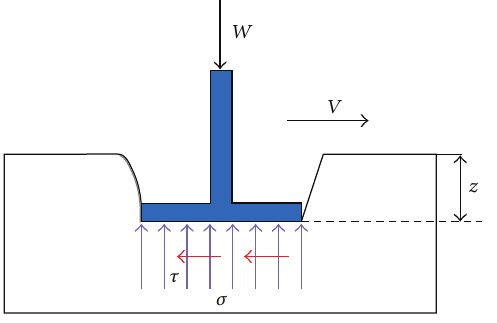
Figure 1: Bekker’s contact model.